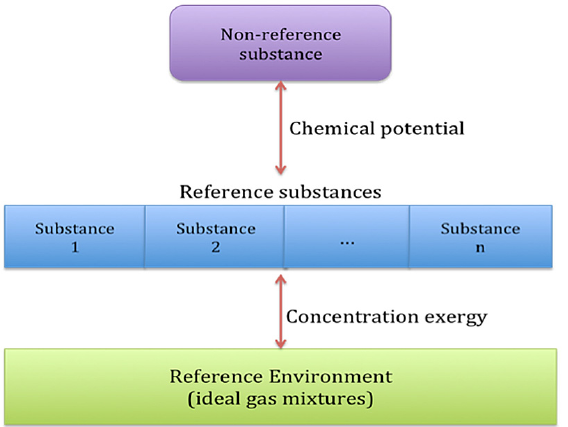
Figure 1. Graphical representation of Szargut’s defined reference